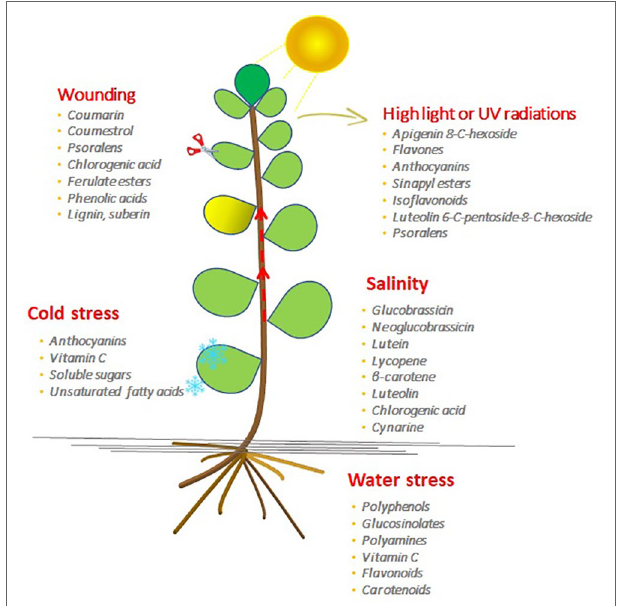
FIGURE 2 | The bioactive molecule accumulation in plants induced by the different abiotic